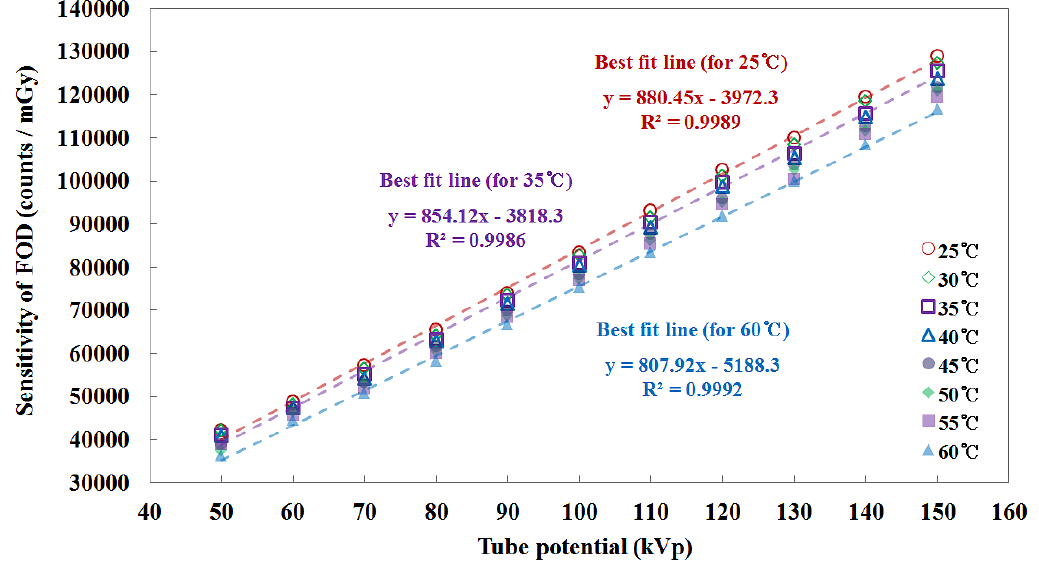
Figure 7. Sensitivity of the FOD as a function of the tube